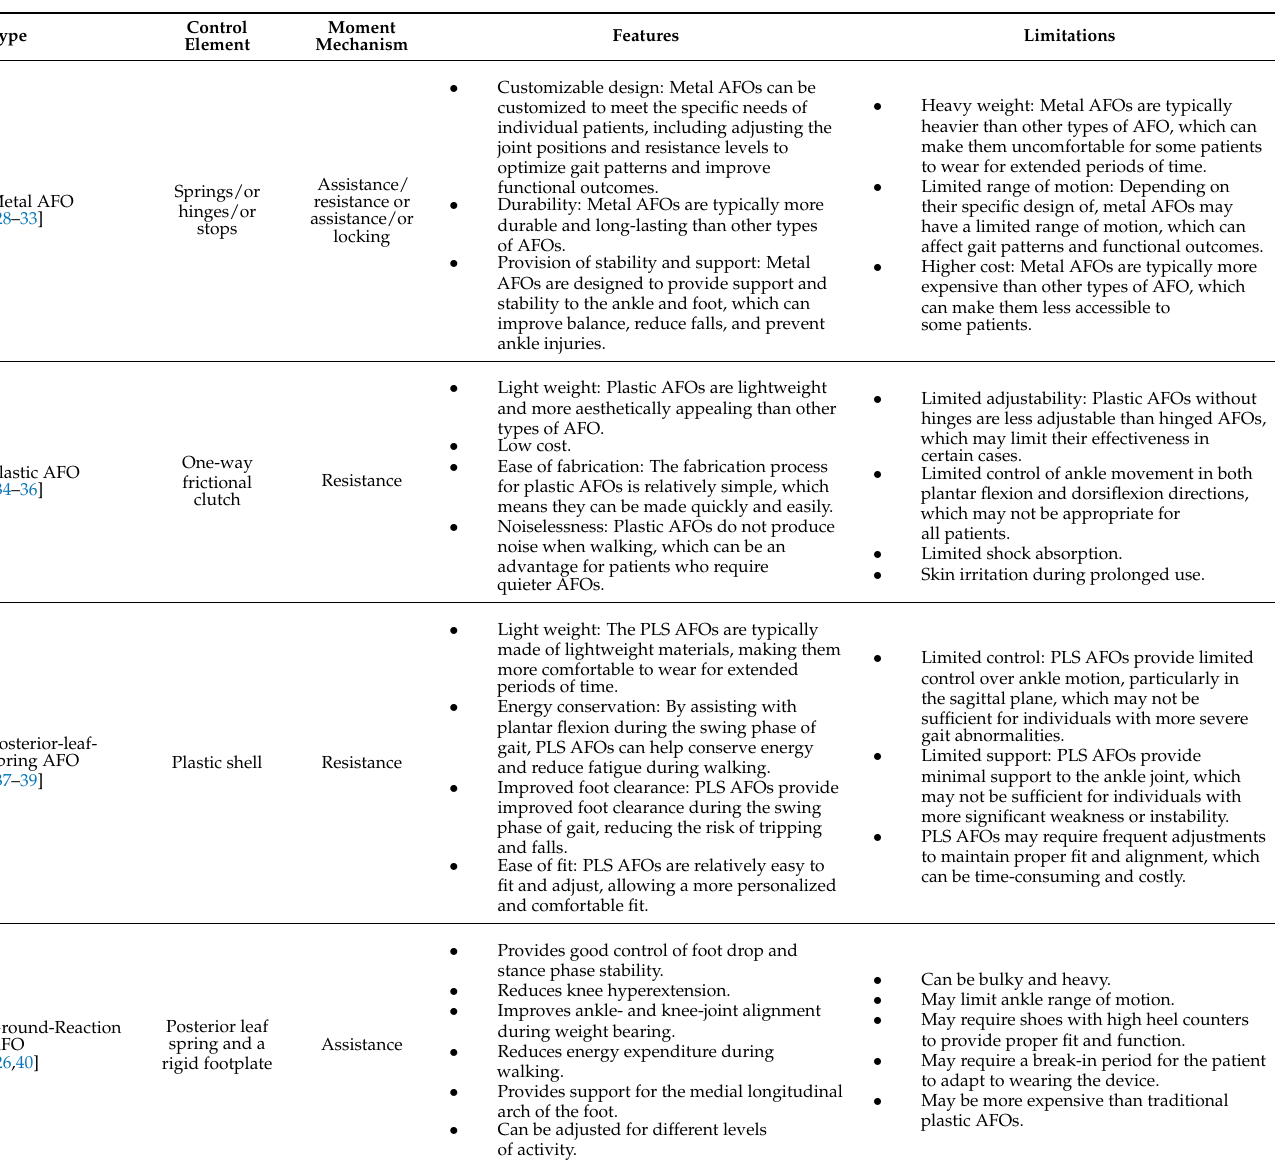
Table 1. Detailed summary of the passive articulated and non-articulated ankle–foot-orthosis